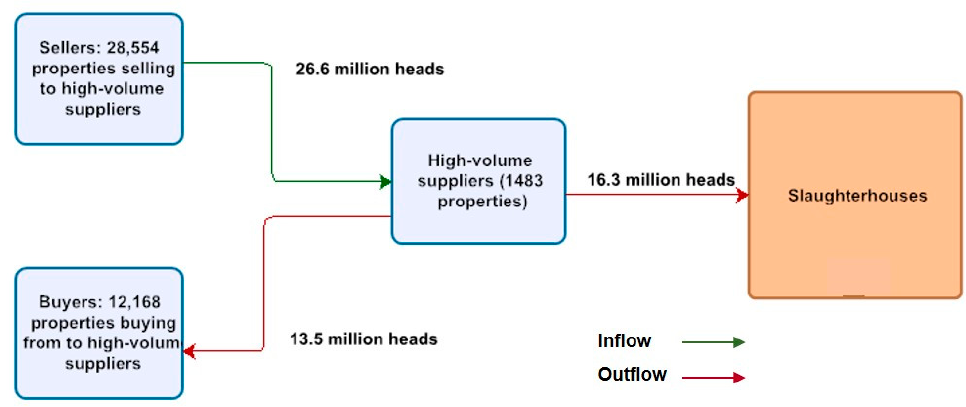
Figure 2. Structure of the cattle supply chain analyzed including the connections of high-volume suppliers.